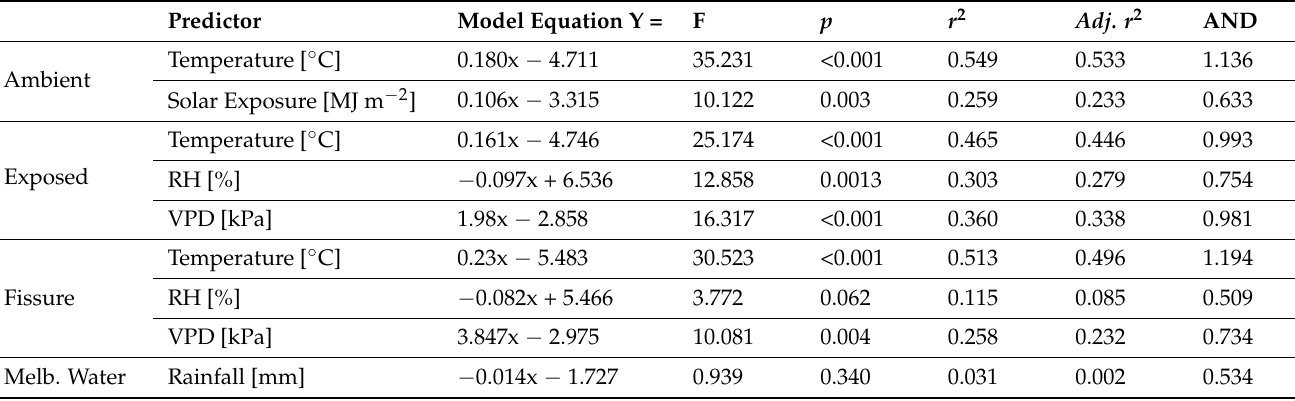
Table A11. Summary of climate regression models predicting log (mean HPI density [no cm − 2 ]). Climate records used in models represent the fortnightly mean value of daily maximum, except rainfall; recorded cumulatively in millimetres. N = 30 for each regression analysis. The absence of autocorrelation of the data is rejected if the Approximate Nonlinear Durbin-Watson (AND) statistic is less than 0.622 or greater than